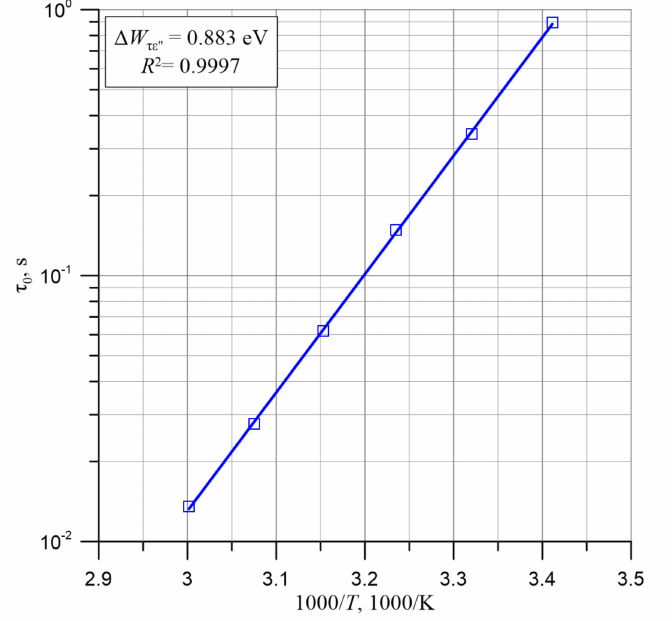
Figure 12. Arrhenius diagram for the values of expected relaxation time, determined from the position of the imaginary permittivity component frequency dependence maximum and its linear